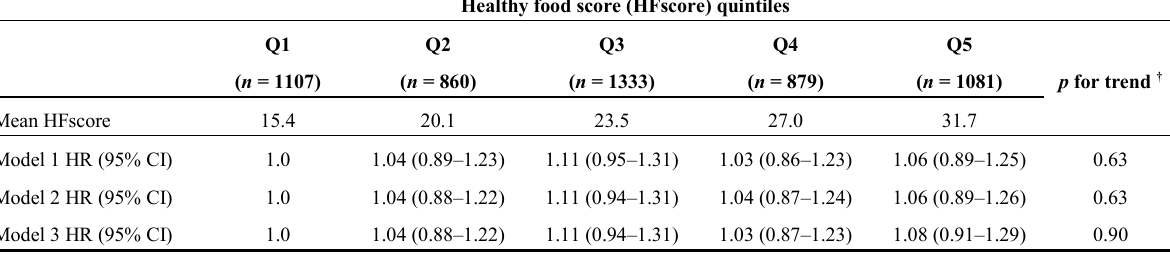
Table 3. Hazard ratios (HR) and 95% confidence intervals (95% CI) for incident